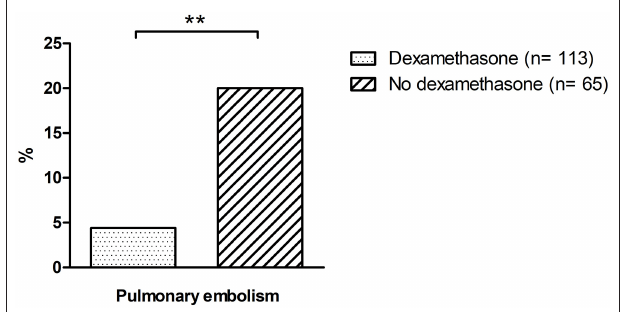
FIGURE 2 | Incidence of pulmonary embolism in patients treated with dexamethasone vs. controls. * indicates a p of < 0.05; ** a p of < 0.01 and *** a p of < 0.001; n.s., not significant.